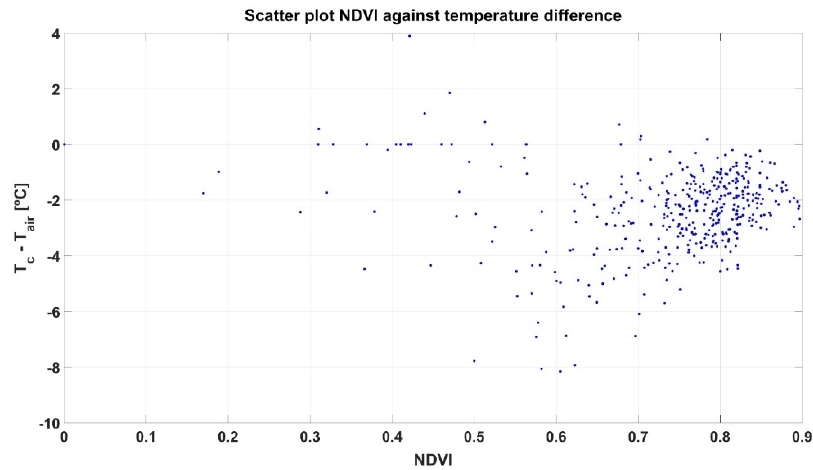
Figure 9. Scatter plot of grid cells for correlation between NDVI and ∆ T in the data from Map A.